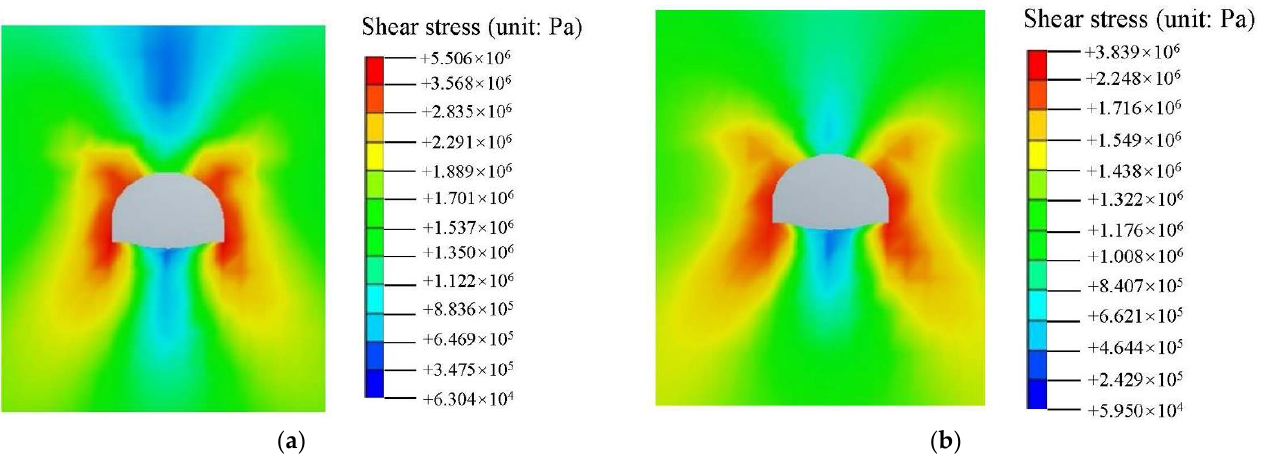
Figure 19. Maps of shear stress of surrounding rock: ( a ) original design scheme; ( b ) scheme after collapse treatment.